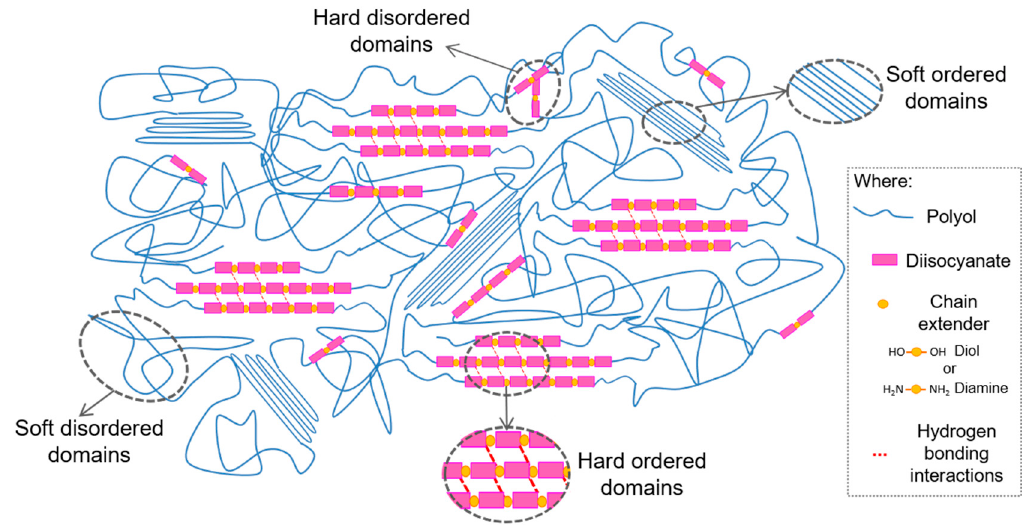
Figure 1. Scheme of segment conformations and hydrogen bonding interactions of polyurethanes or polyurethane-ureas, and the resulting ordered and disordered microdomains.